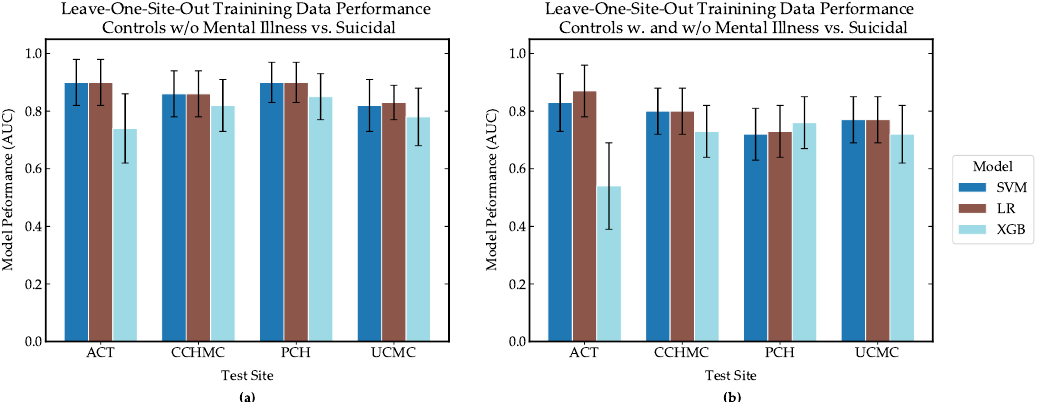
Figure 2. Leave-one-site-out results for training data with di ff erent machine learning (ML) models using ( a ) controls without mental illness and suicidal thoughts, and ( b ) controls with and without mental illness and suicidal thoughts. Error bars indicate a 95% confidence interval. ML models used include logistic regression (LR), support vector machines (SVM), and extreme gradient boosting (XGB). Studies and test sites include the ACT study (collected at UCMC) and the STM study collected at CCHMC, PCH, and